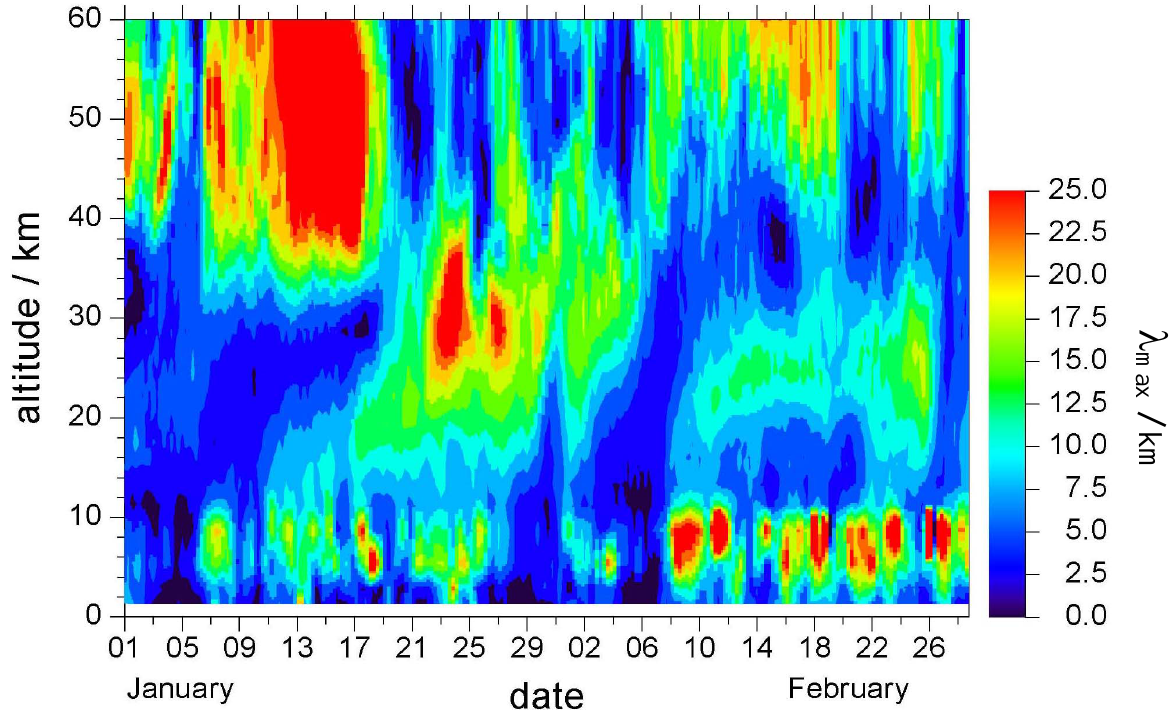
Fig. 4. Critical level calculation for Esrange with ECMWF T106 data. The abscissa shows the date of January/February 2003, the ordinate the altitude and the colour code the maximum vertical wavelength λ max , which can penetrate through the respective atmospheric levels. Dark blue areas are critical levels which inhibit vertical propagation of internal gravity waves.